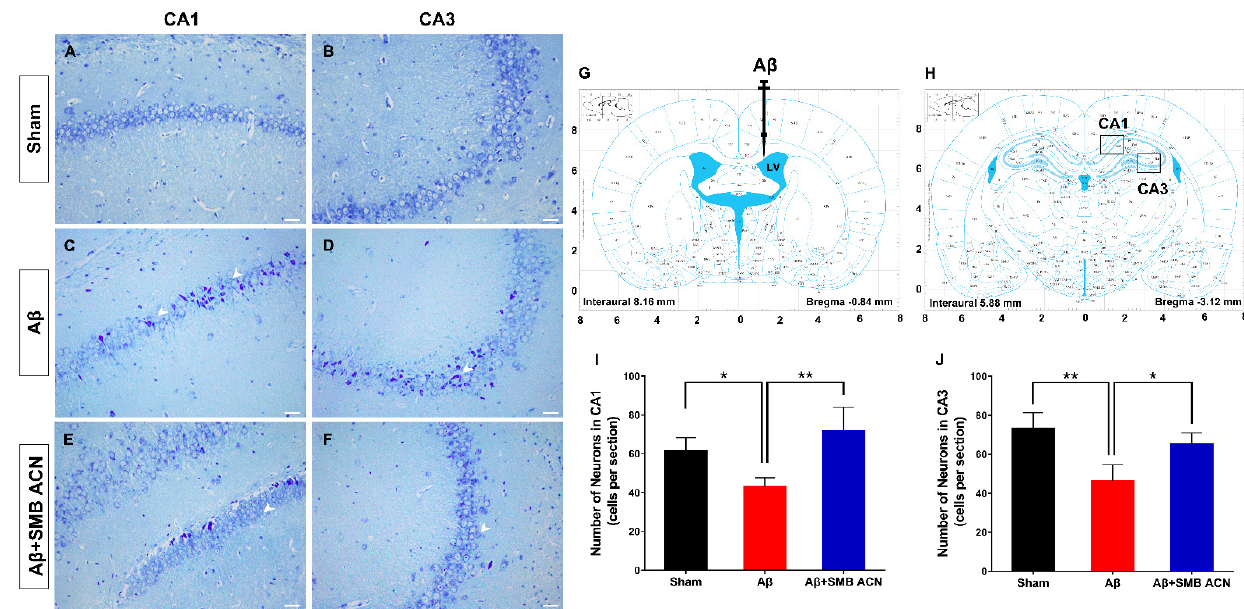
Figure 6. Representative images of Nissl staining in the CA1 and CA3 regions of the hippocampus of sham group ( A , B ), A β group ( C , D ), and A β + SMB ACN group ( E , F ). ( G ) The site of intracerebral ventricle injection in rat brain (Black) and the sites of the section in CA1 and CA3 region of the hippocampus ( H ). The number indicated the surviving neurons in CA1 ( I ) and CA3 ( J ), * p < 0.05 and ** p < 0.01. Stained sections of each group were viewed at 200 × magnification. Scale bar = 100 μ m.